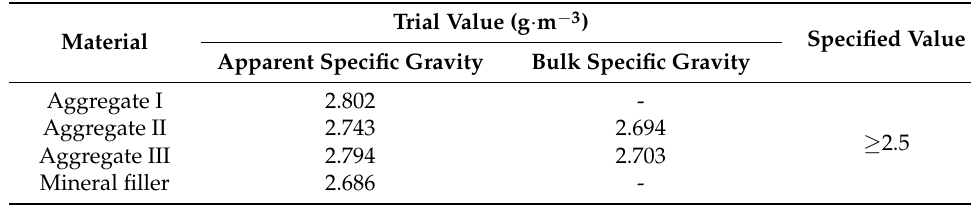
Table 3. Density test of materials.